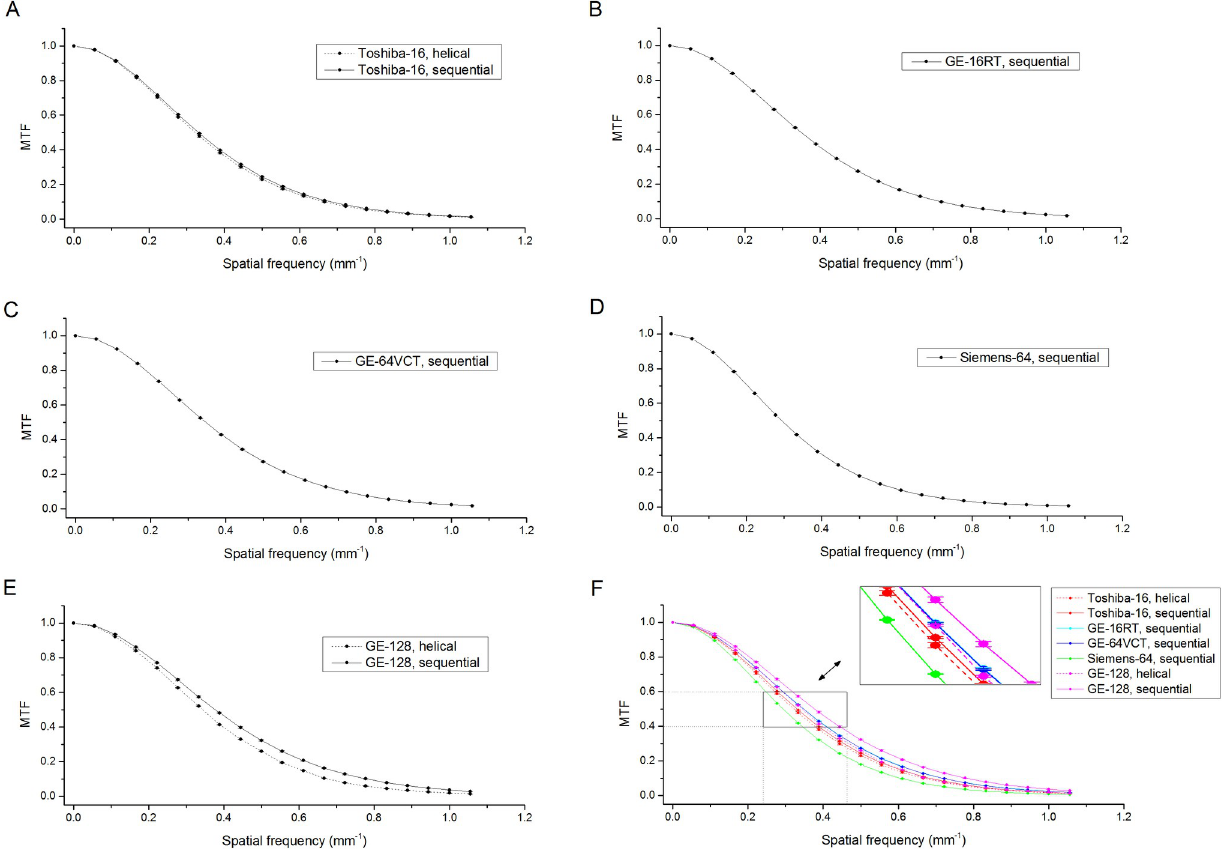
Fig 3. Modulation transfer function (MTF) curves of images acquired using different CT scanners/acquisitions protocols. Panels A, B, C, D and E show the MTF curves (mean ± standard deviation across five repeated measurements) for Toshiba-16, GE-16RT, GE-64VCT, Siemens-64 and GE-128 scanners, respectively. In order to better compare the different MTF curves, Panel F shows on the same graphic the MTF curves for all scanners/ acquisition protocols, with a zoomed in version for the 40%-60% range of MTF.